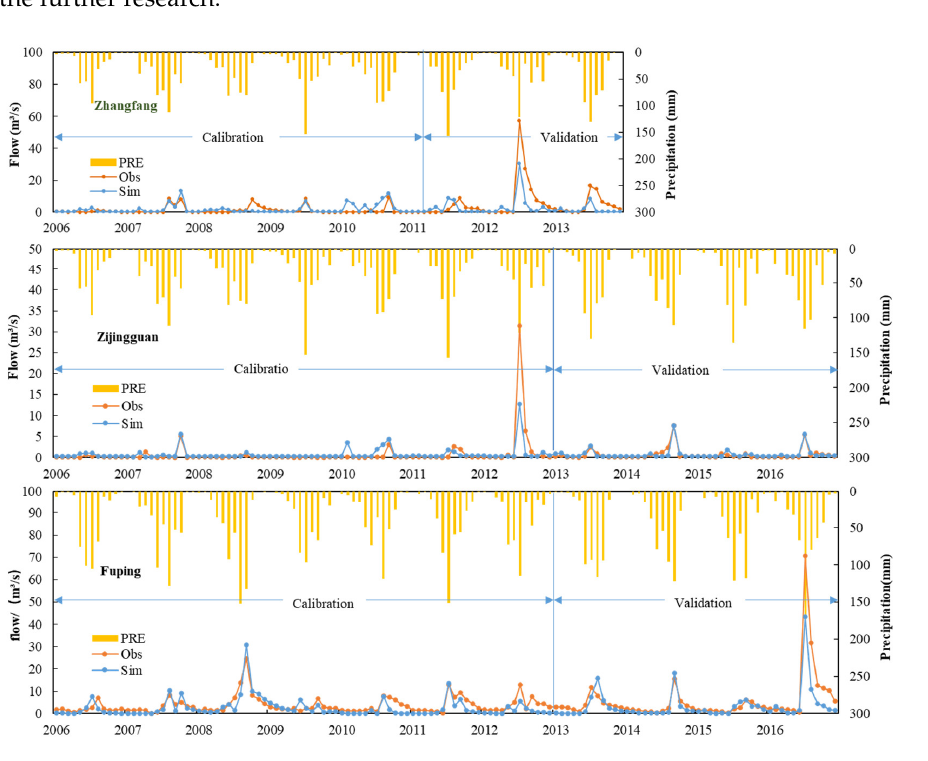
Figure 5. Measured and simulated values of NH 3 -N (Taitou Station). 3.2. Water Quantity and Water Quality Early Warning 3.2.1. Water Quantity Early Warning Due to the fact that Zijingguan and Zhangfang are driven by Yuxian meteorological data, while Fuping County is driven by Lingqiu meteorological data, the data of the Yuxian and Lingqiu meteorological stations were used in this paper as the meteorological data required for scene simulation. By analyzing the measured rainfall data of the Daqing River Basin from 1951 to 2019, the daily rainfall in the recurrence intervals of the Yuxian and Lingqiu meteorological stations was calculated and determined (Table 3), which was taken as the input item of rainfall scene, and the daily average runoffs of Zijingguan, Zhangfang, and Fuping were simulated.